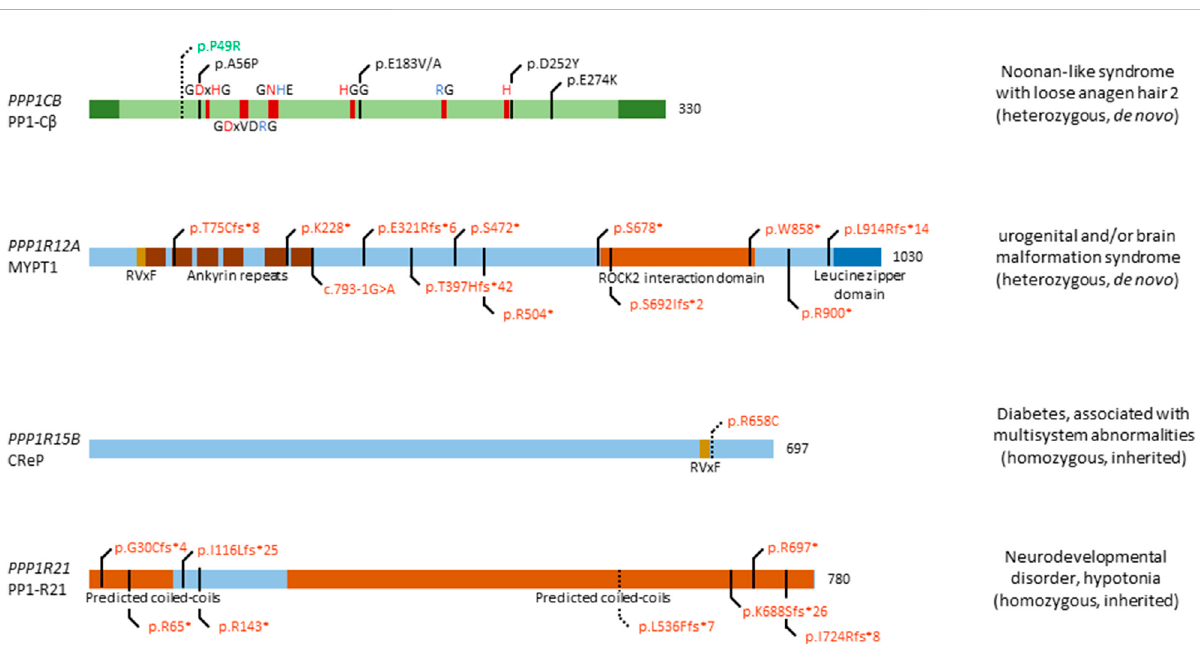
FIGURE 2 Overviewofcongenitaldisease-causingvariantsinsubunitsofPP1.Intotal,5distinctgeneticvariantshavebeenfoundin PPP1CB ,encodingthe PP1 catalytic subunit β isoform; 12 variants in PPP1R12A , encoding the myosin targeting subunit protein 1 (MYPT1); 1 variant in PPP1R15B , encoding the Constitutive repressor of eIF2 α phosphorylation (CReP); and 8 mutations in PPP1R21 , encoding the PP1 regulatory subunit 21 (PP1-R21). Variants in green denote alleged or proven gain-of-function mutants, variants in red: loss-of-function mutants, variants in black: pathogenic mechanismunknown.Dottedlinesnearvariantsdenotethatfunctionaldatahaveprovenpathogenicity.Additionalstructuralandregulatorydomains in the PP1 subunits are indicated, as well as conserved amino acids of the catalytic subunit (red amino acids denote metal binding, blue denote phosphate binding). RVxF denotes the most recurrent PP1 catalytic subunit binding